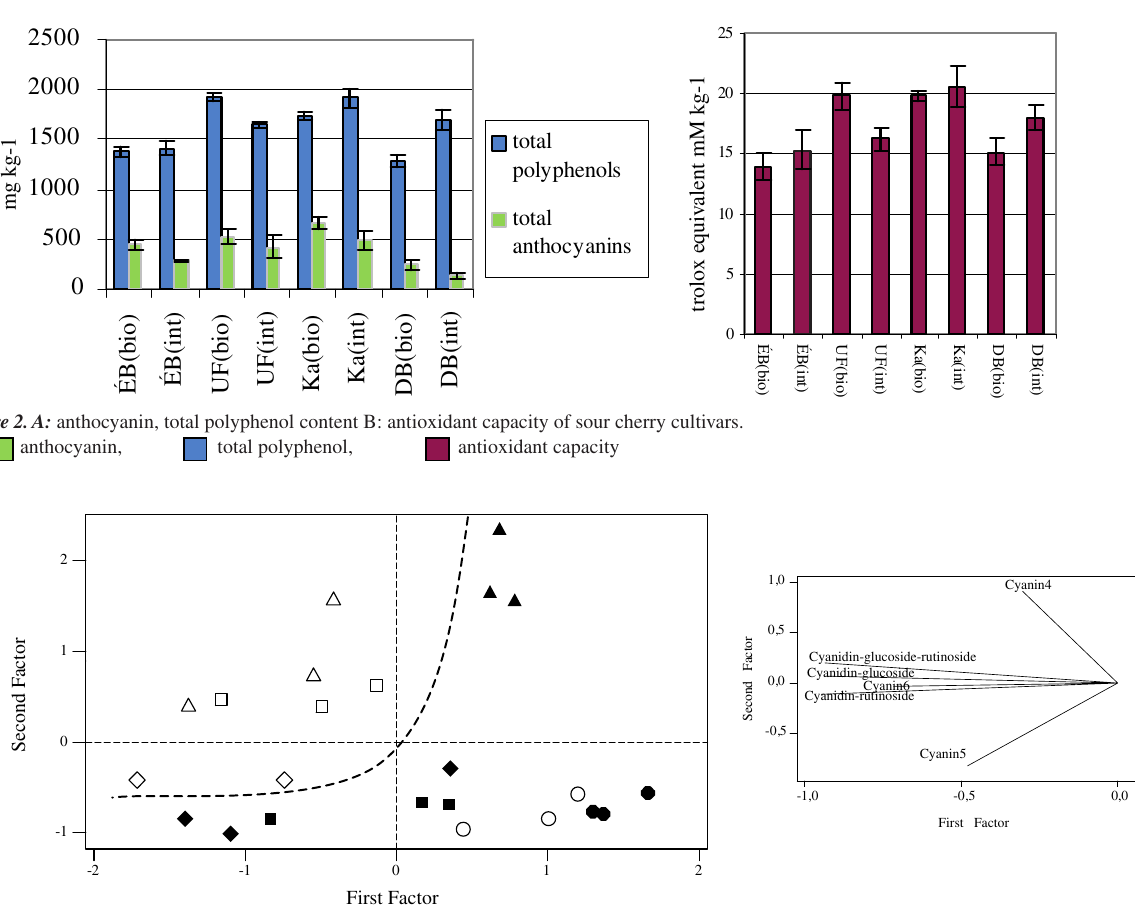
Figure 3. Effect of bio and integrated cultivation technology on anthocyanin composition of sour cherry cultivars, Score (A) and loading (B) plot of first two Factors. Variables: cyanidin (cy)-glucosyl-rutinoside, cy-glucoside, cy-rutinoside, unknown anthocyanin4, anthocyanin5, anthocyanin6. ÉB ? (int), ?? (bio), Ká ? (int) ?? (bio), UF ? (int) ?? (bio), DB ? (int) ??